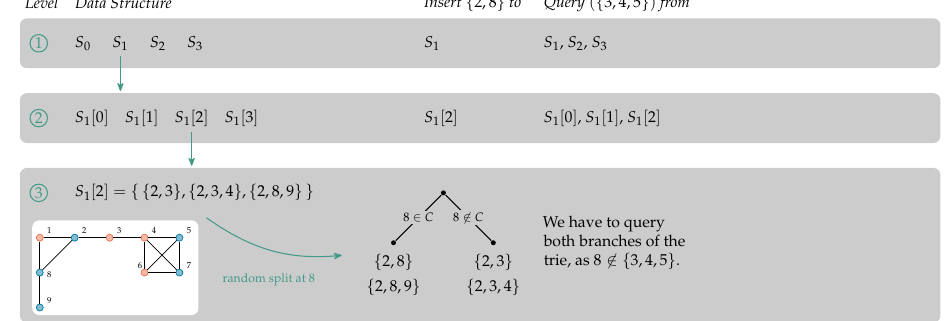
2,8 is illustrated: the { } 2,8 has two { } ) 3,4,5 { }